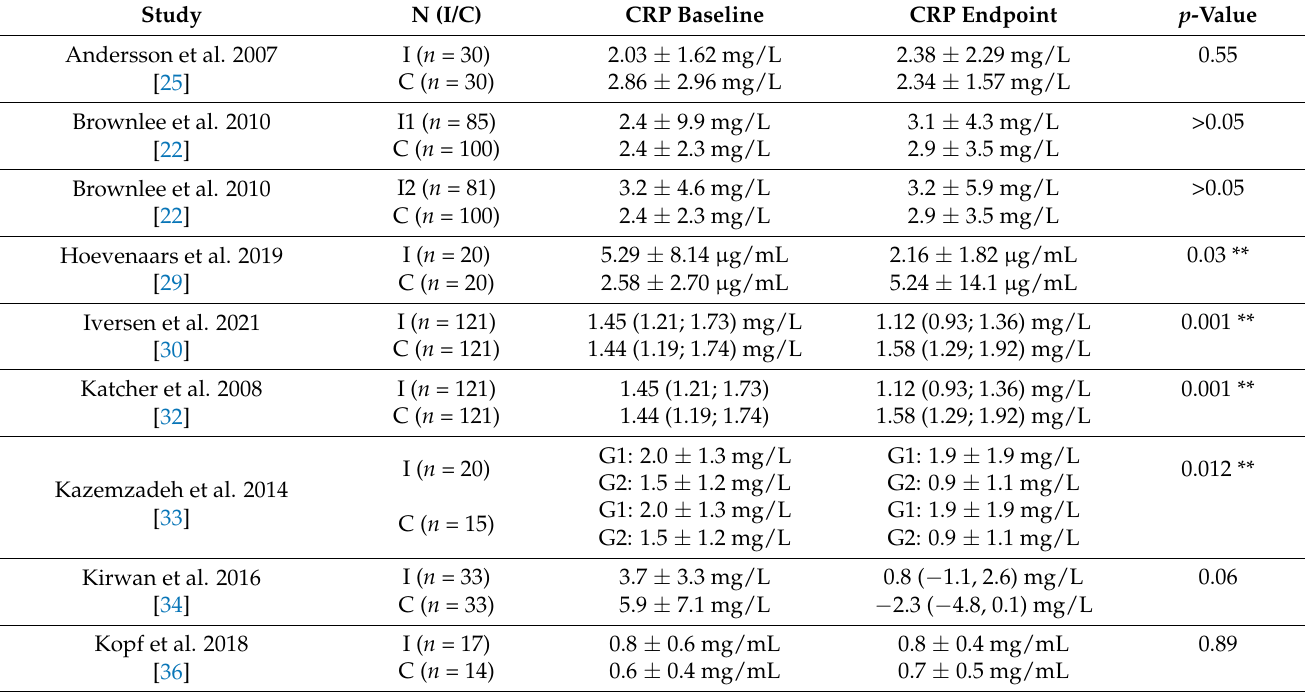
Table 3. Effect of whole grain consumption on inflammatory markers in overweight and obese